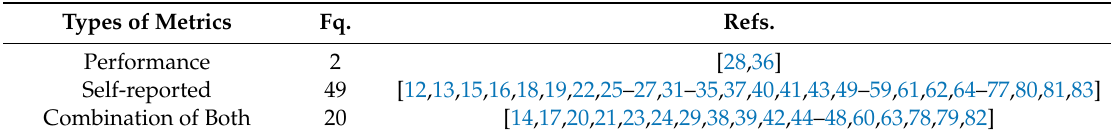
Table 9. Types of usability metrics category.